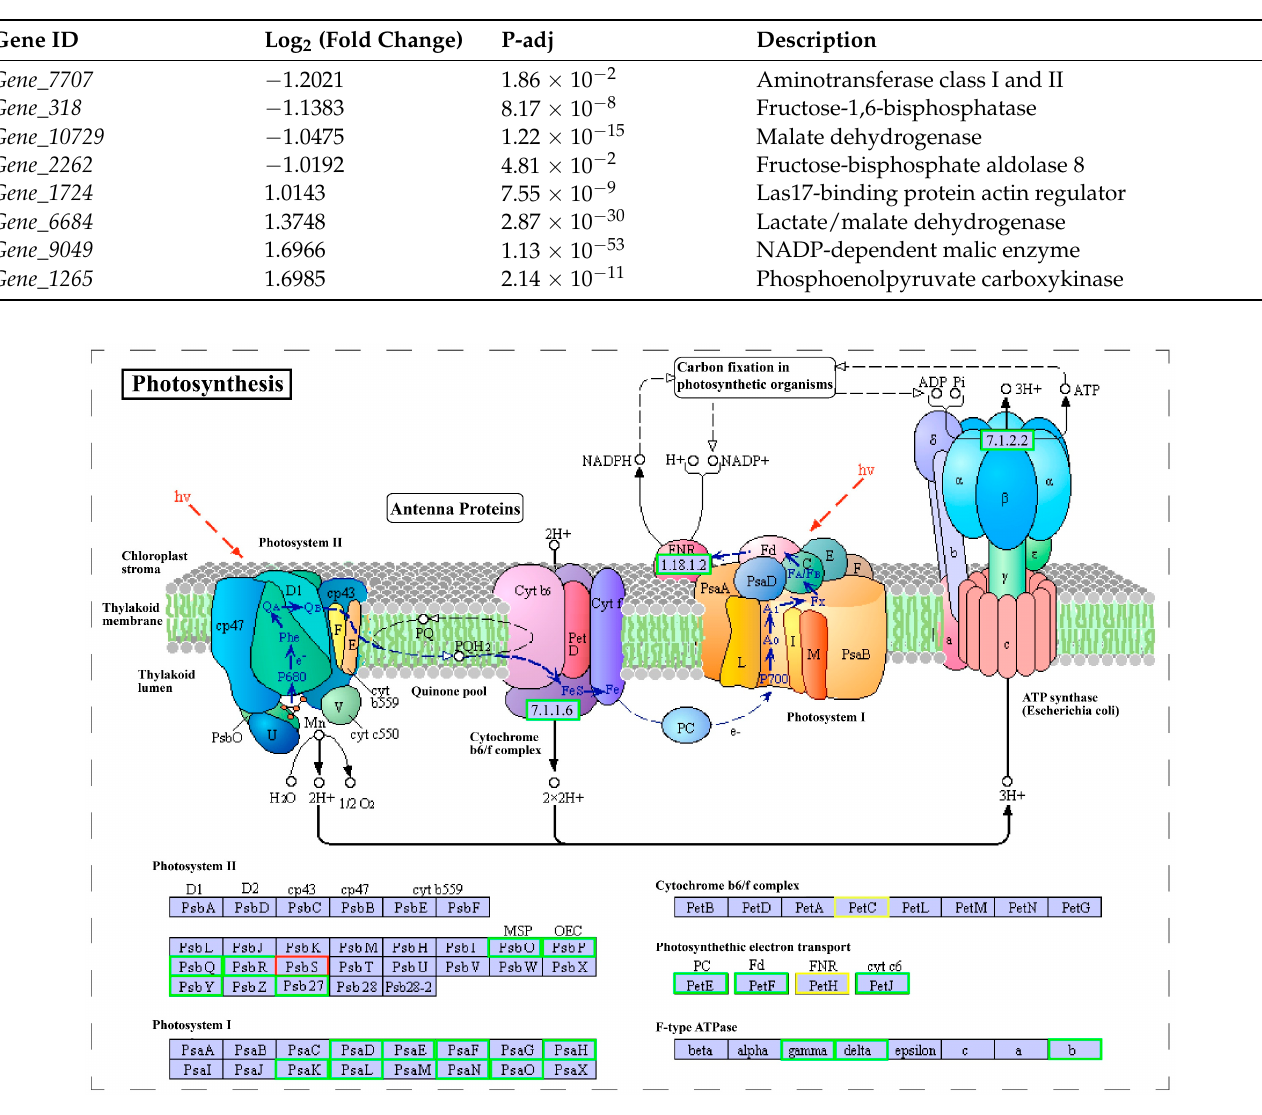
Figure 7. DEGs involved in the regulation of photosynthesis in Chlorella sorokiniana DP-1. Green boxes represent downregulated genes, red boxes indicate upregulated genes, and yellow boxes represent both up- and down-regulated